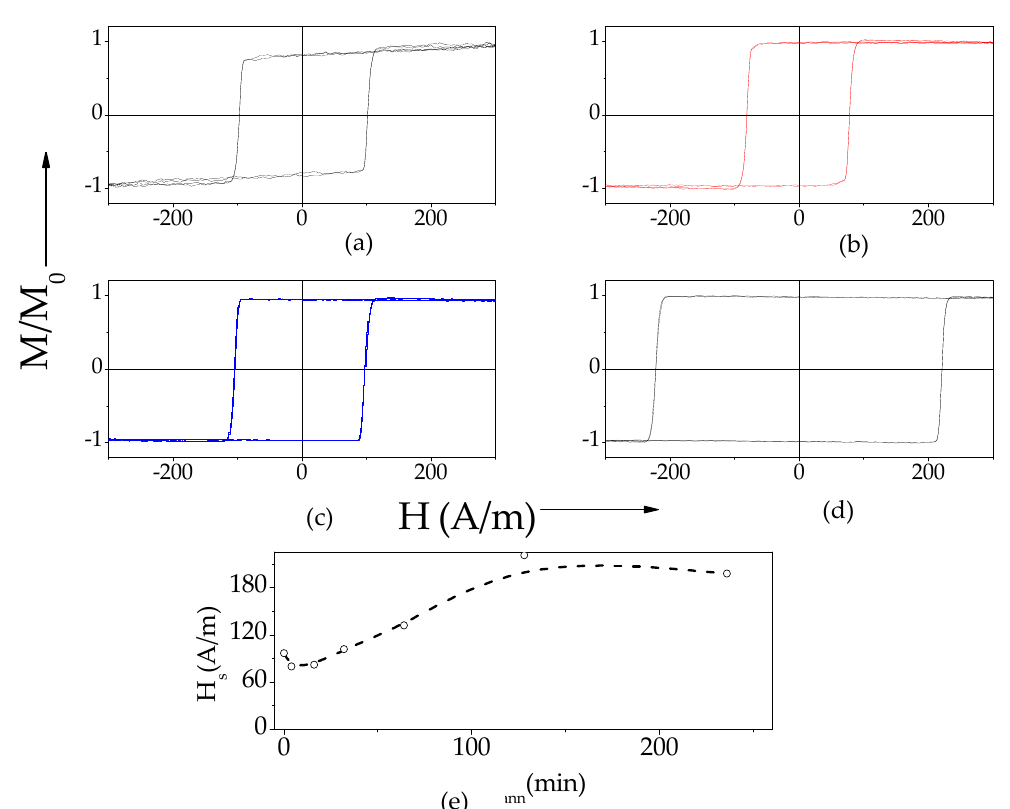
Figure 14. Hysteresis loops of as-prepared ( a ) and annealed at T ann = 410 °C for t ann = 4 min ( b ), 32 min ( c ), 128 min ( d ), and H c (t ann ) dependence ( e ) for Fe 49.6 Ni 27.9 Si 7.5 B 15 microwires. The lines in ( e ) are just a guide to the eyes. (Reproduced with permission from [63]. Figure 11 Copyright © 2021 MDPI Publishing, Open Access).